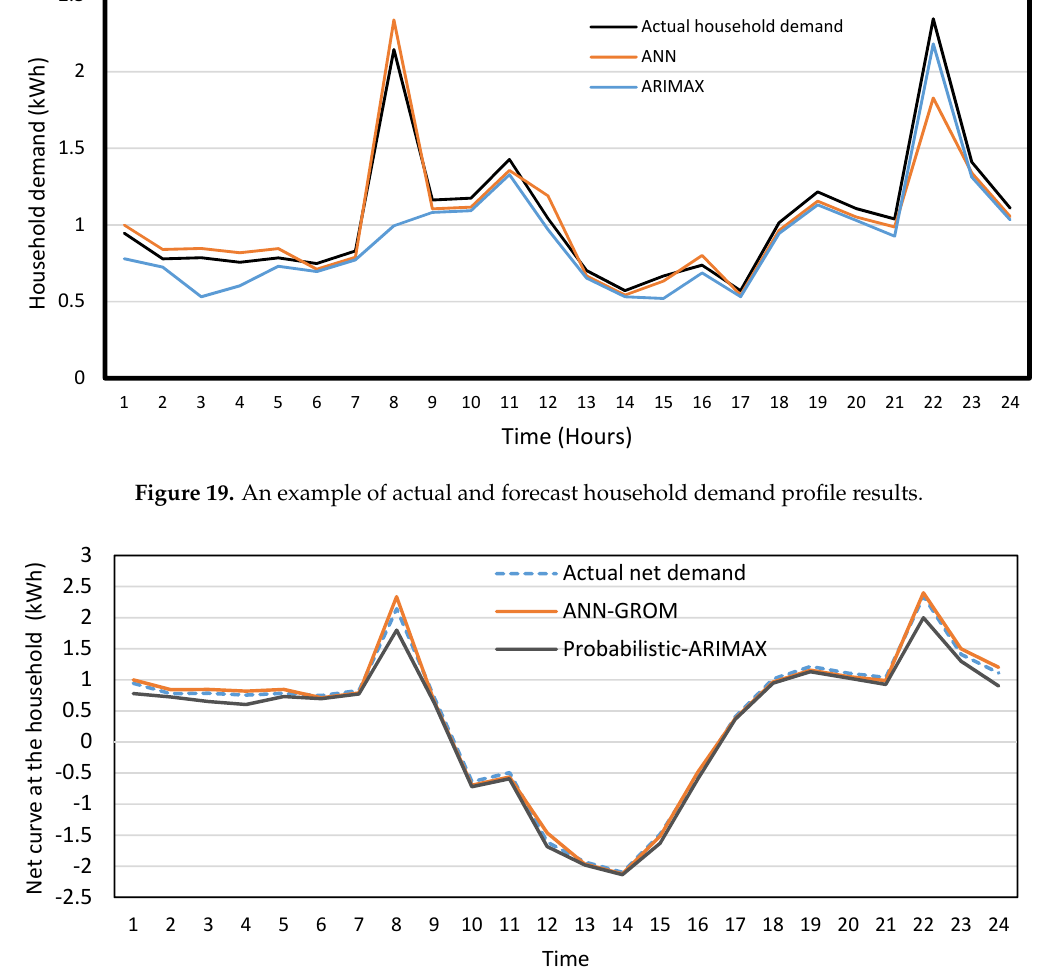
Figure 20. An example of actual and forecast net demand profile.